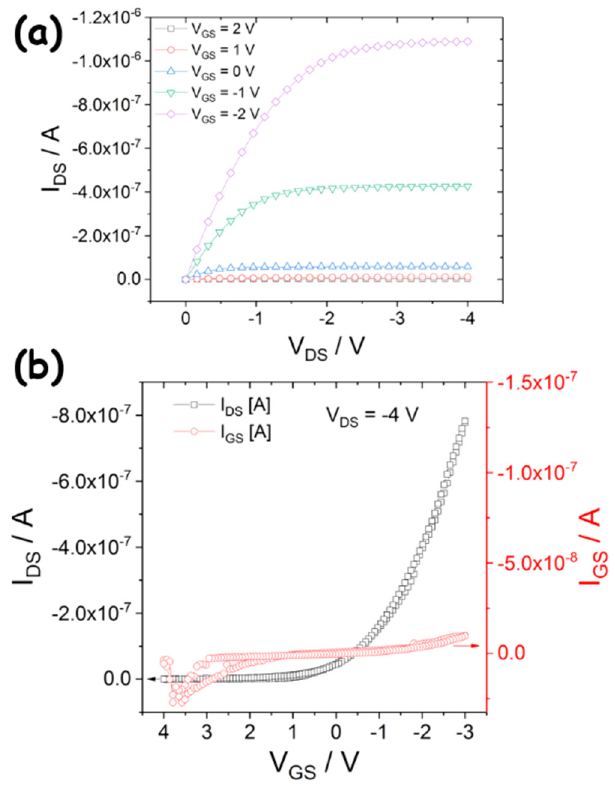
Figure 6. Output ( a ) and transfer characteristic curve ( b ) of an ultra-conformable OFET transferred onto the skin.